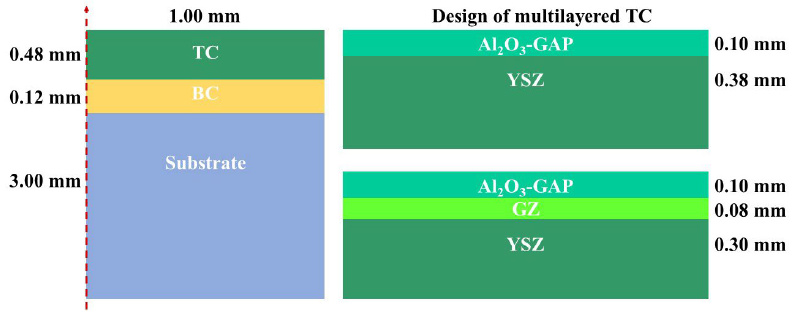
Figure 2. Schematic illustration of finite element model and its design of multilayer TC.